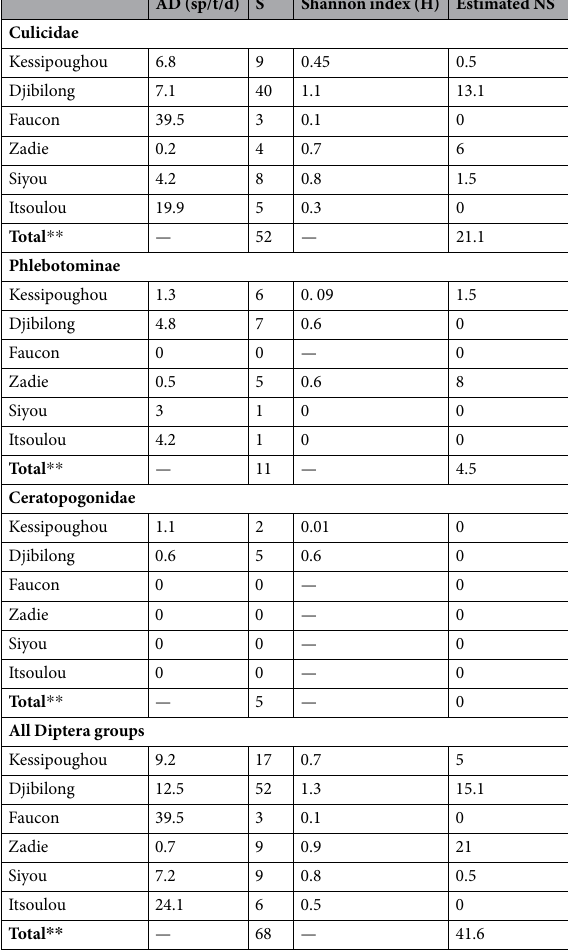
Table 1. Density and diversity of the Diptera assemblages in the different caves. The number of sampling events was 44 in both Kessipoughou and Djibilong caves, 4 in Faucon, Zadie and Itsoulou caves, and 2 in Siyou cave. —, not applicable” or not calculated data; ** “Total” refers to the total number of collected species for the species richness (S), and to the sum of non-sampled (NS) species for the NS column in all caves; AD, apparent density (number of specimens collected per trap and per day; sp/t/d); H, diversity